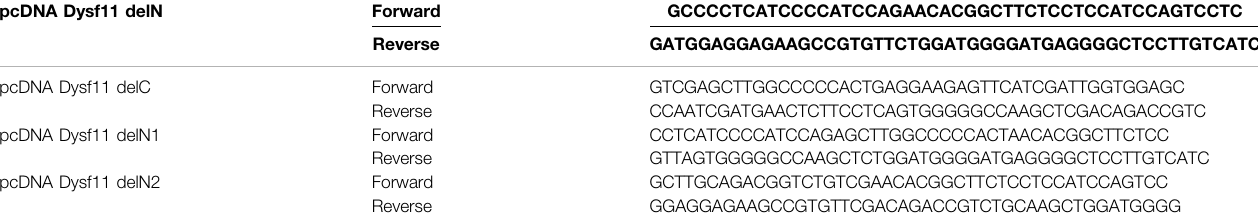
TABLE 1 | Primers used to create dysferlin11 constructs by PCR fusion. pcDNA Dysf11